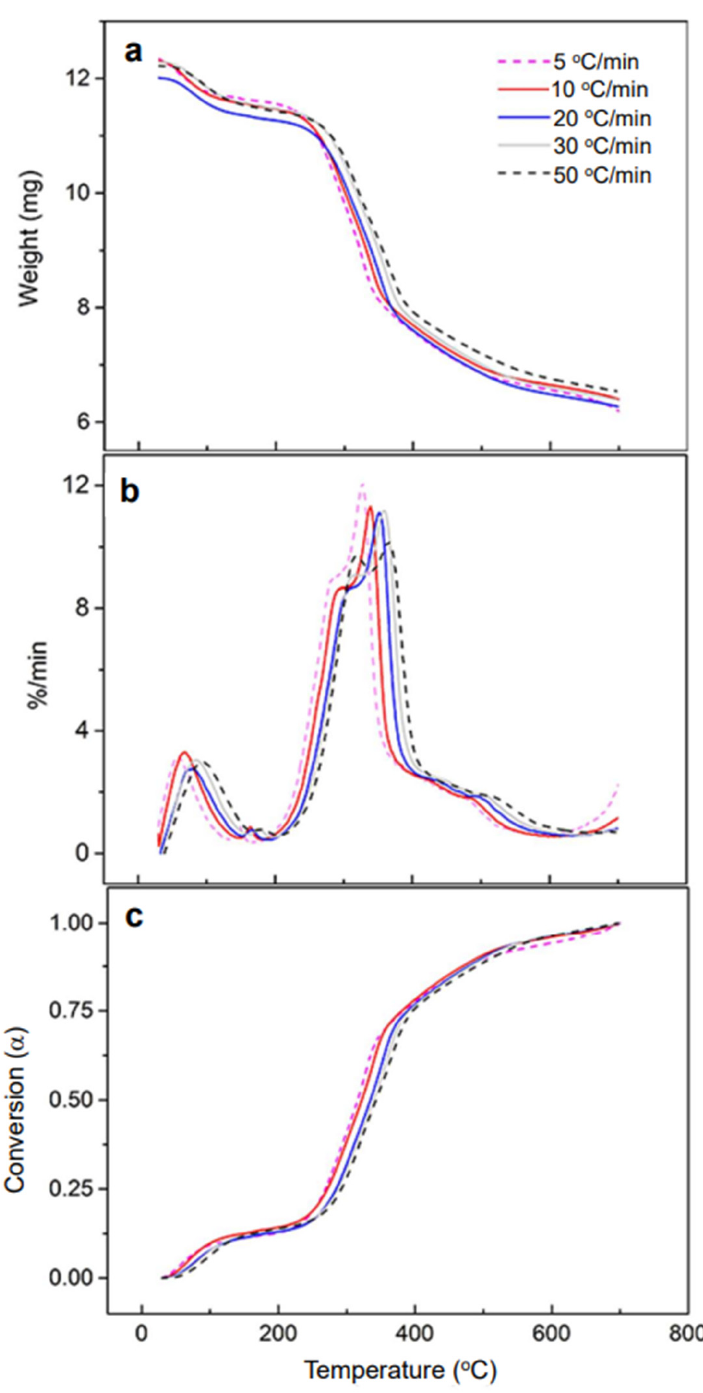
Figure 2. ( a ) TG, ( b ) DTG and ( c ) conversion curve derived from the thermogravimetric analysis of chicken manure.